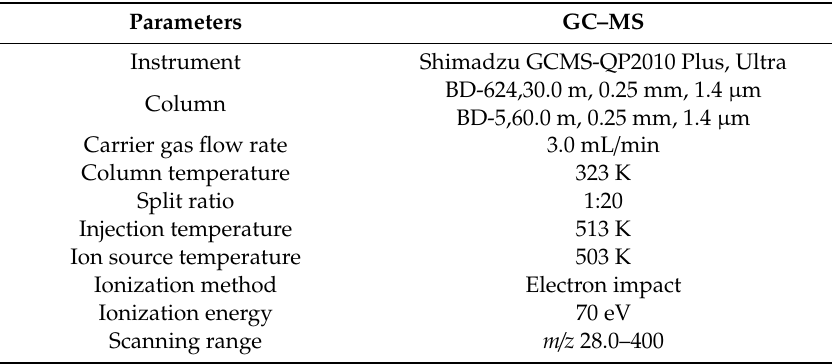
Table 3. GC–MS operation